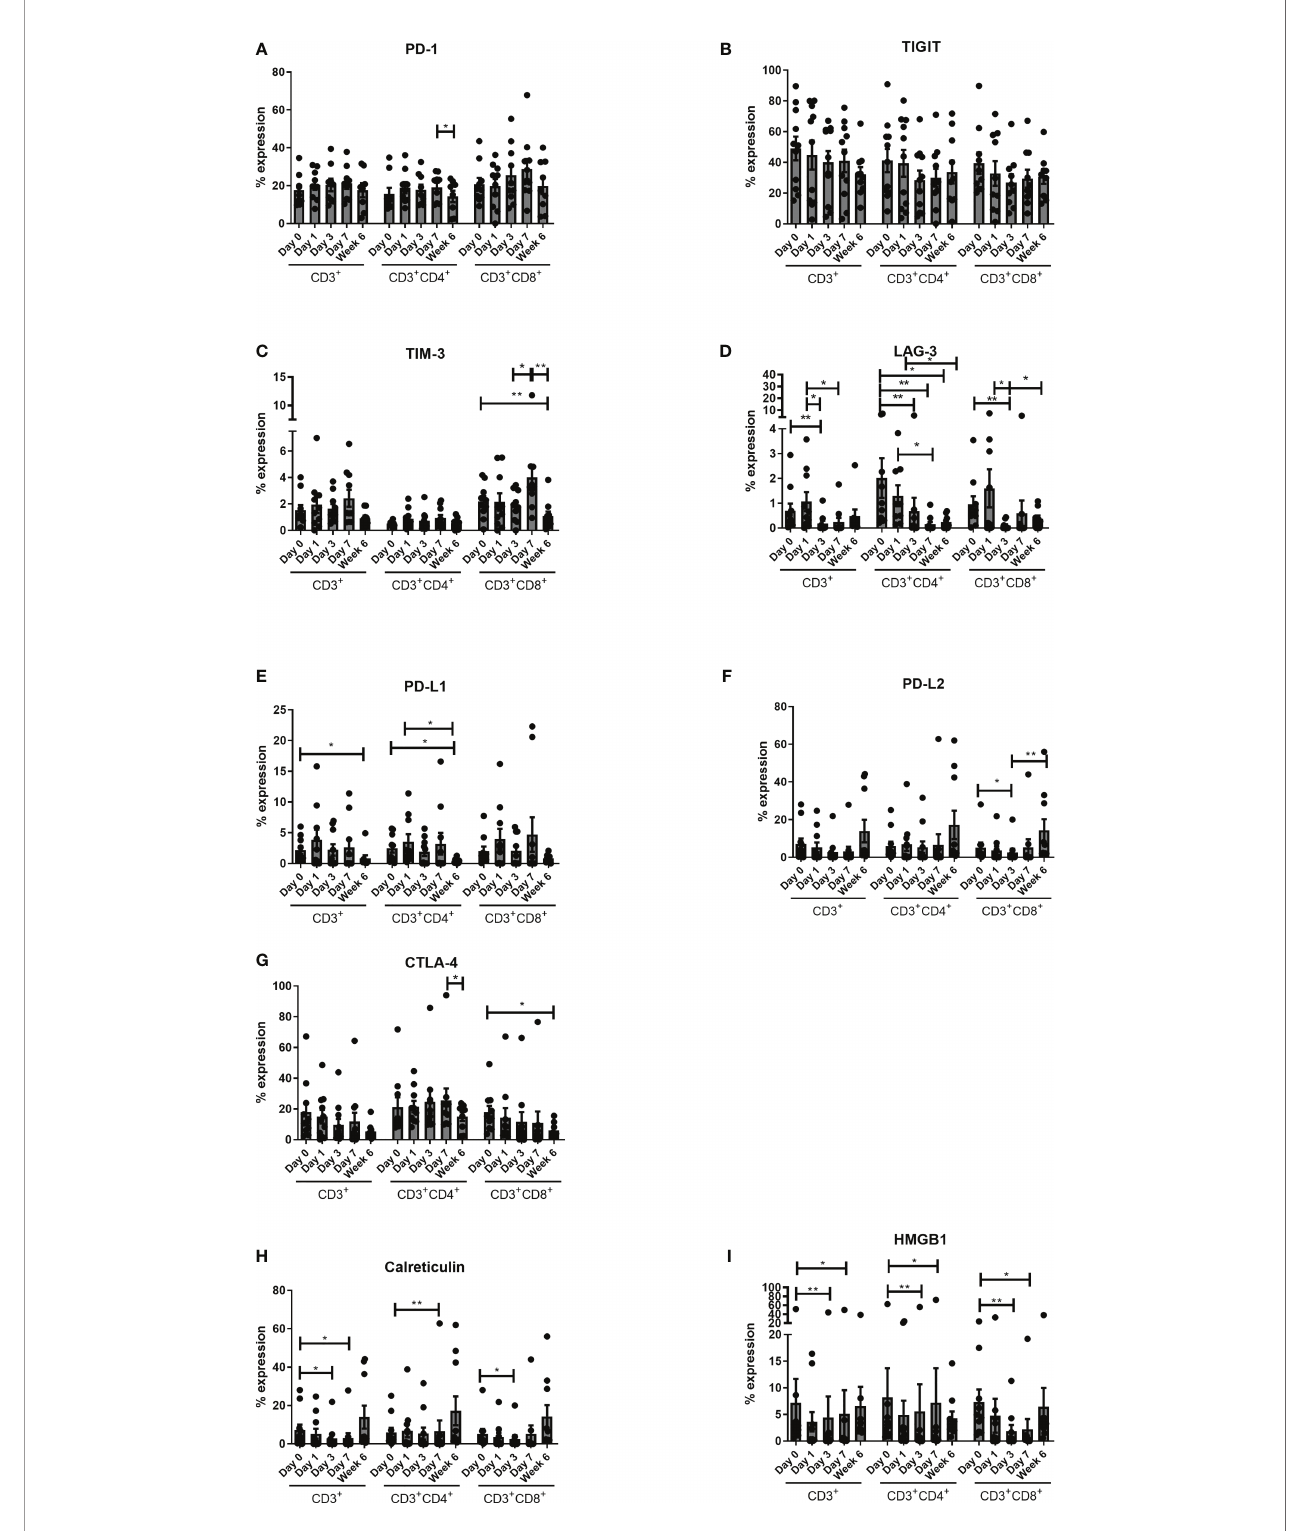
FIGURE 4 | Expression of circulating CD4 + CTLA-4 + cells decrease 6 weeks post-operatively. Expression of inhibitory immune checkpoints PD-1 (A) , TIGIT (B) , TIM- 3 (C) , LAG-3 (D) CTLA-4 (E) , PD-L1 (F) and PD-L2 (G) and DAMPs HMGB1 (H) and Calreticulin (I) were assessed on the surface of circulating CD3 + , CD3 + CD4 + and CD3 + CD8 + cells in OAC patients on POD 0, 1, 3, 7 and 6 weeks post-surgery by fl ow cytometry (n=11). Paired, non-parametric t-test *p<0.05 and